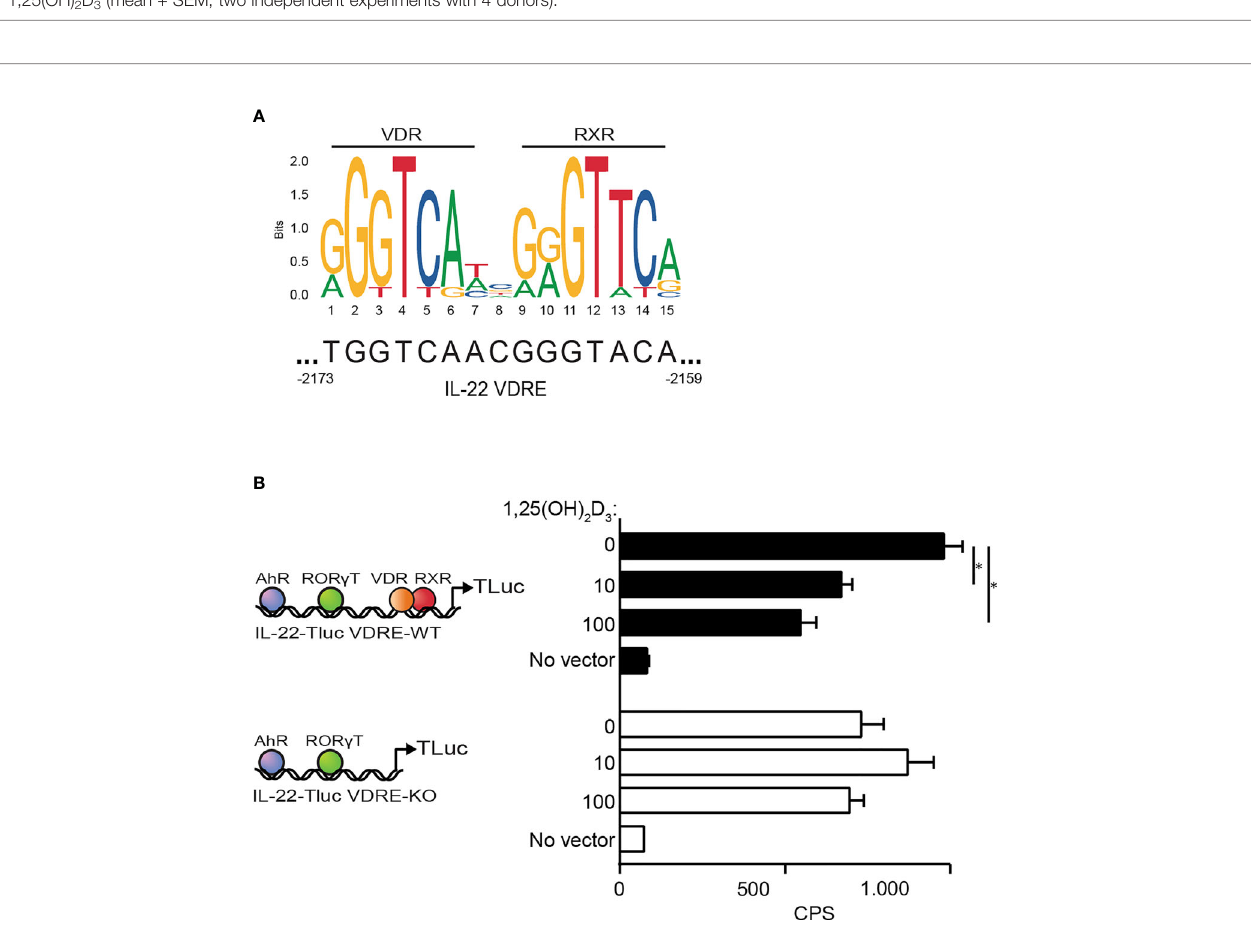
FIGURE 7 | 1,25(OH) 2 D 3 inhibits IL-22 production via a repressive VDRE in the il22 promoter (A) Schematic representation of the transcription factor VDR : RXR and the DNA binding consensus motif as position frequency matrices for VDR : RXR in homo sapiens found in the open-access database JASPAR (48, 49). (B) (Left) Schematic representation of the plasmid construct IL-22-Tluc with the VDRE (IL-22-TLuc VDRE-WT) located at 2159-2173 base pairs upstream the start site of the il22 gene and the plasmid construct IL-22-Tluc with the VDRE deletion (IL-22-TLuc VDRE-KO). (Right) Luciferase light emission in counts per second (CPS) in Myla 2059 cells nucleofected either with IL-22-TLuc VDRE-WT (black) or IL-22-TLuc VDRE-KO (white) plasmids and cultured for 48 h in the presence of 1,25(OH) 2 D 3 at the indicated concentrations in nM (mean + SEM, three independent Myla 2059 cells transfected with the IL22-TLuc VDRE-KO the vectors and compared luciferase light emission in untreated vector ( Figure 7B ). These data indicated that the il22 cells and in cells treated with 1,25(OH) 2 D 3 . We found that 1,25 promoter contains a repressive VDRE located 2159-2173 base (OH) 2 D 3 inhibited luciferase light emission in Myla 2059 cells pairs upstream from the start codon of the il22 gene. transfected with the IL22-TLuc VDRE-WT vector but not in